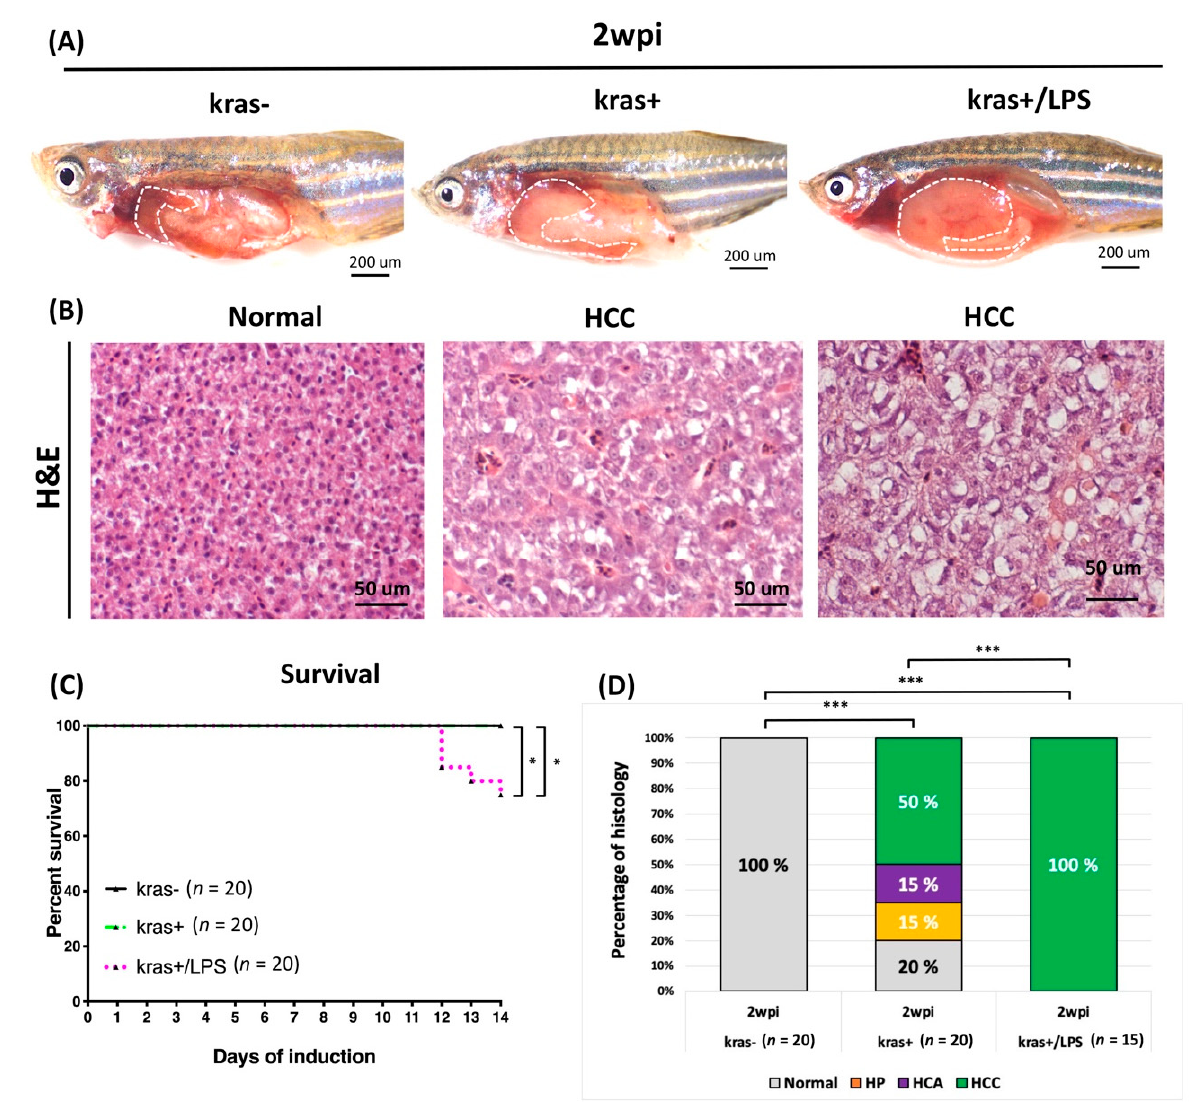
Figure 6. LPS promoted HCC progression in adult kras + transgenic zebrafish. The wild-type ( kras − ) control, kras+, and kras+ / LPS transgenic zebrafish were treated at 4 mpf with 10 μ g/mL Dox alone or with 10 μ g/mL Dox + 40ng/mL LPS, and samples were taken at 2 wpi. ( A ) The upper row shows the internal organs of the abdomen, and ( B ) the lower row displays H&E staining of liver sections (white dotted frame: liver). ( C ) Kaplan-Meier survival curves reveal the percentage of survival at 2 wpi. ( D ) Histological analysis shows that kras+ and kras+ / LPS transgenic zebrafish developed HCC at 2 wpi. Scale bar: 50 or 200 μ m. Student’s t -test or one-way ANOVA were used to assess differences between variables: * p < 0.05, *** p < 0.001.